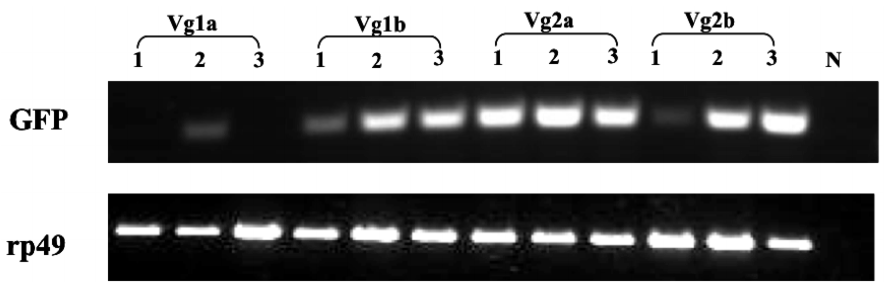
Figure 2. Expression of GFP gene in transgenic Drosophila by RT-PCR. Three independent lines for each promoter were assayed. The constitutive ribosomal protein 49 gene ( rp49 ) in D. melanogaster was examined as an endogenous control. N = negative control.